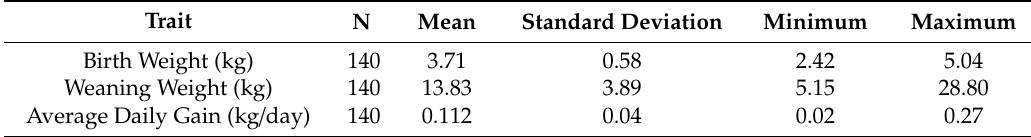
Table 3. Descriptive statistics of lamb growth traits.